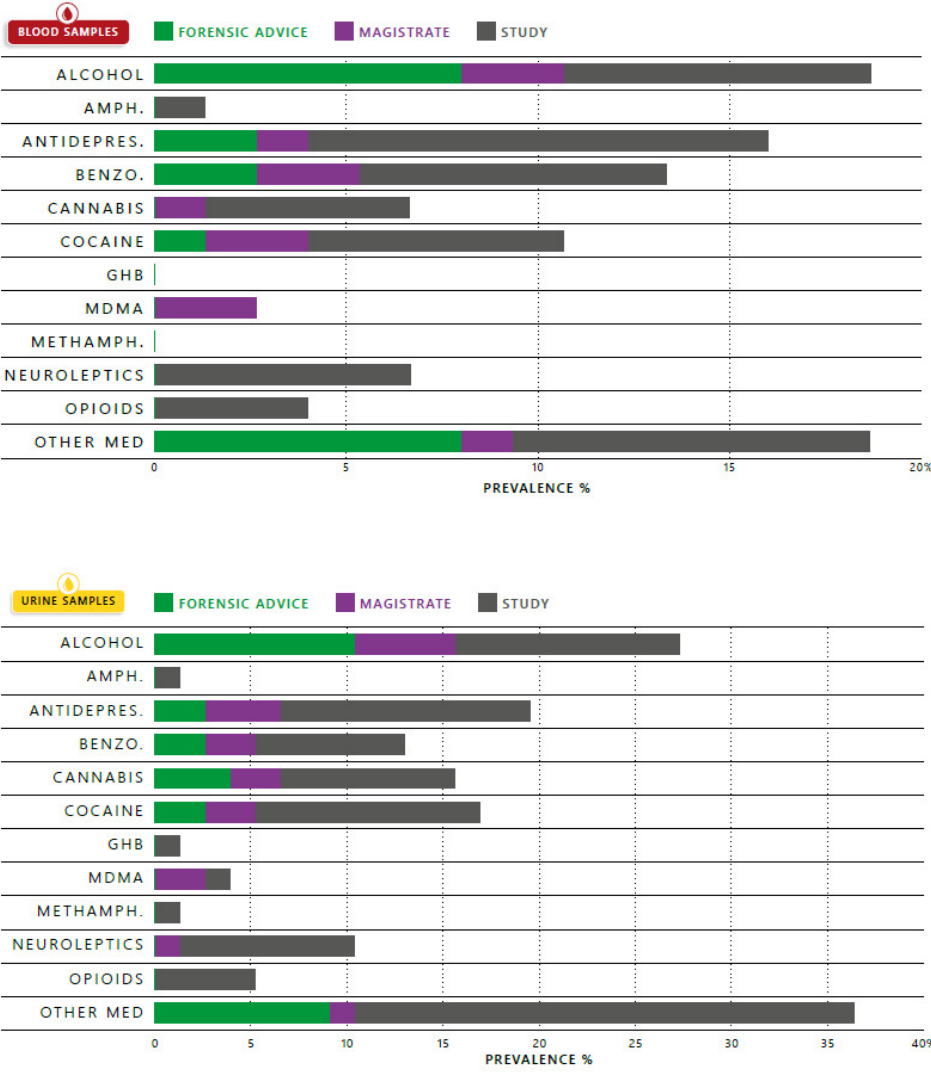
Figure 1. Prevalence of compounds in blood and urine samples indicated in percentage. FA: samples selected via forensic advice ( n = 15); MAG: samples selected via magistrates ( n = 13); study samples ( n = 51); Amph: amphetamine; Antidepres: antidepressants; Benzo: benzodiazepines, Methamph: methamphetamine; Other Med: other medication—painkillers, heart-medication, anti-histaminics, antibacterial or antifungal medication, methylphenidate, diabetic medication.